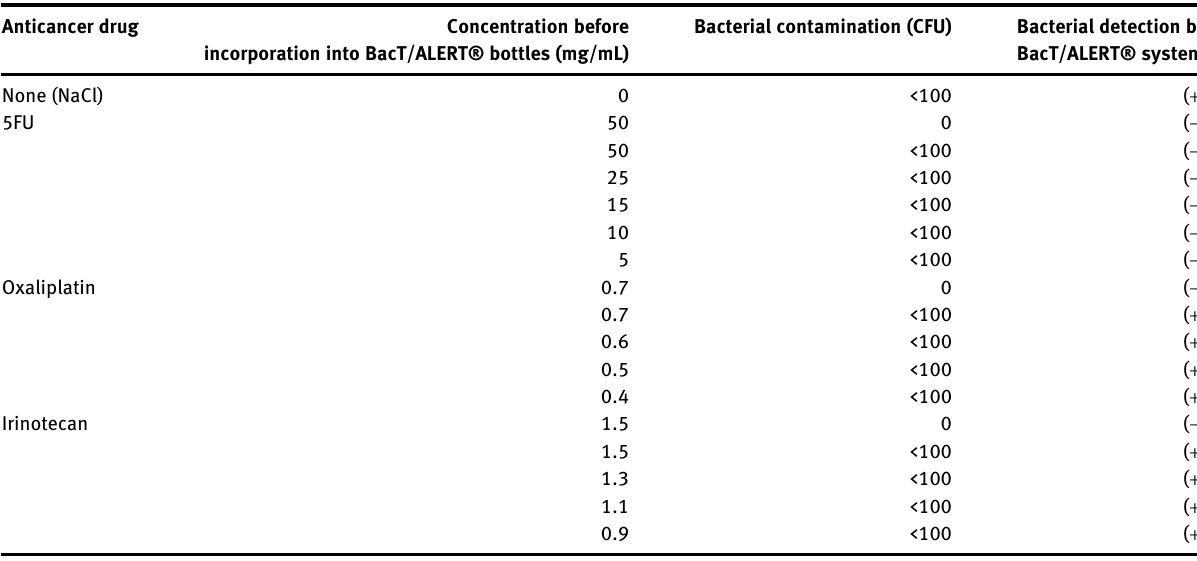
Table  : Bacterial detection of contaminated sample with BacT/ALERT® system.